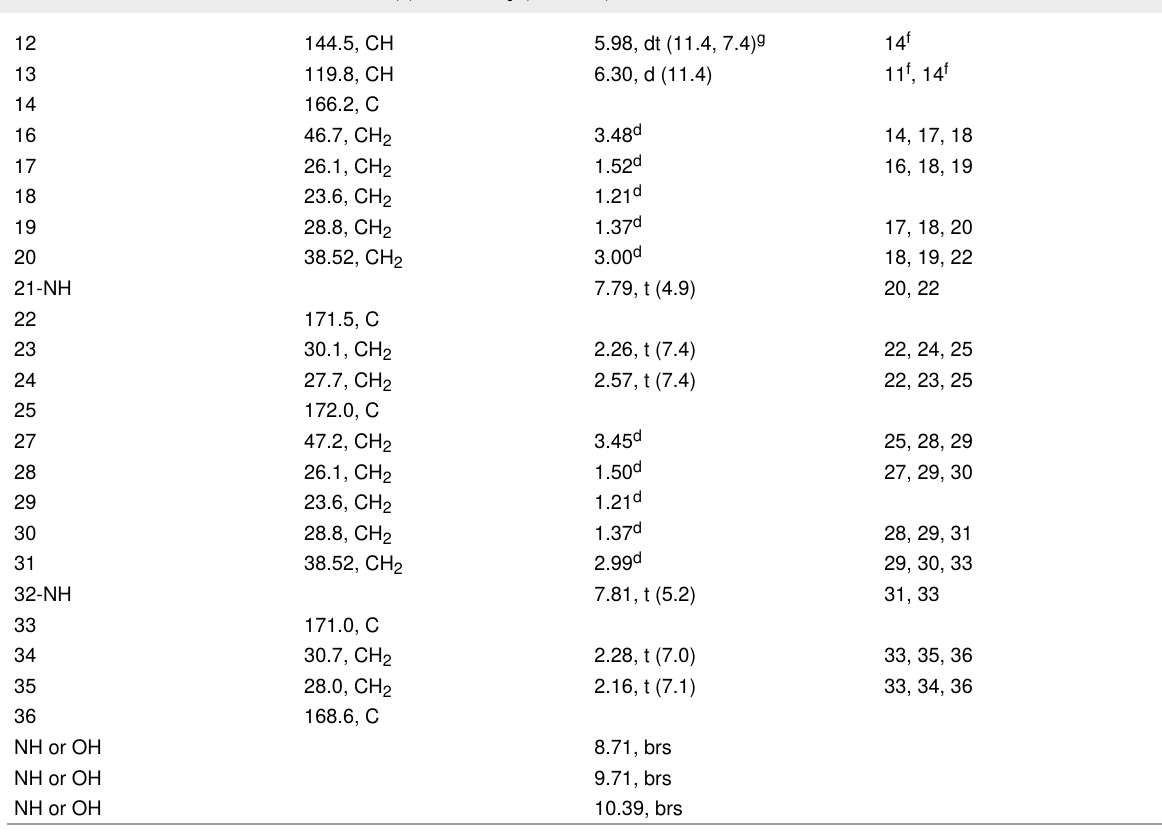
Table 1: 1 H and 13 C NMR data for tenacibactin K ( 1 ) in DMSO- d 6 . (continued)